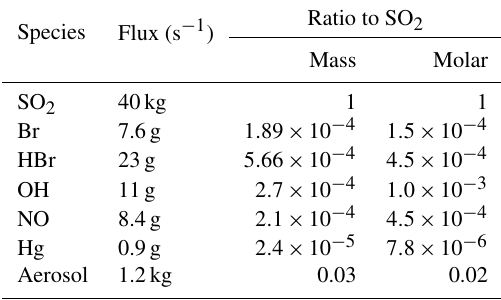
Table 1. Volcanic emission fluxes in the main model